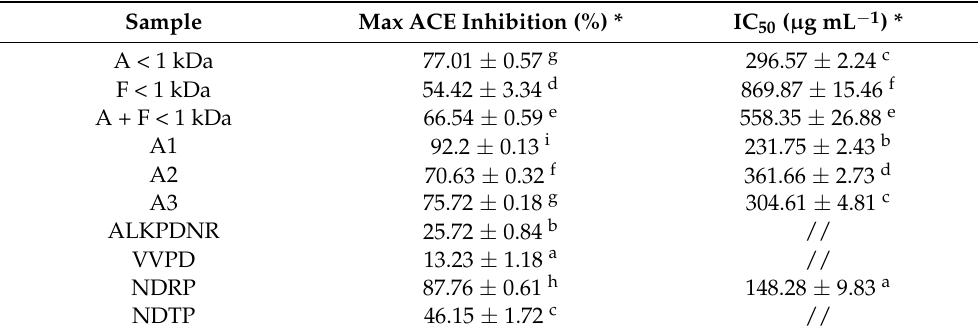
Table 2. Angiotensin-I-converting enzyme (ACE) inhibitory activity of three SPH < 1 kDa (A < 1 kDa; F < 1 kDa; A + F < 1 kDa), of three isolated RP-HPLC fractions from A < 1 kDa (A1; A2; A3) and of four peptides prepared by chemical